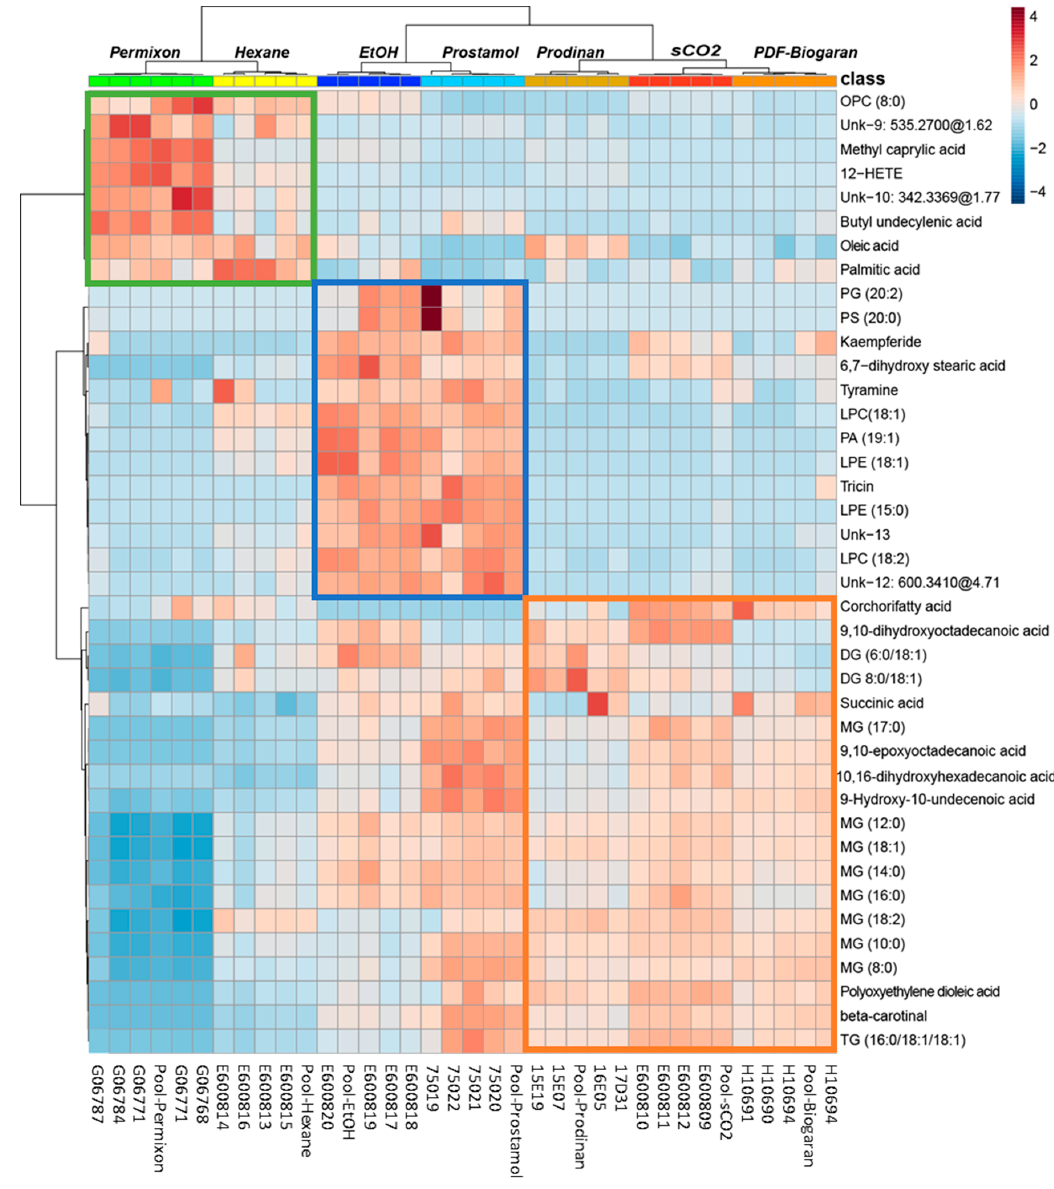
Figure 5. The heatmap combined with a hierarchical cluster analysis of the top 40 VIP ranked features from the OPLS-DA model. Spots are colored according to their peak area in each sample normalized to TIC and Pareto scaled. Colored squares highlight representative features of each extraction process. Laboratory extracts: EtOH: ethanolic; sCO 2 : supercritical carbon dioxide;